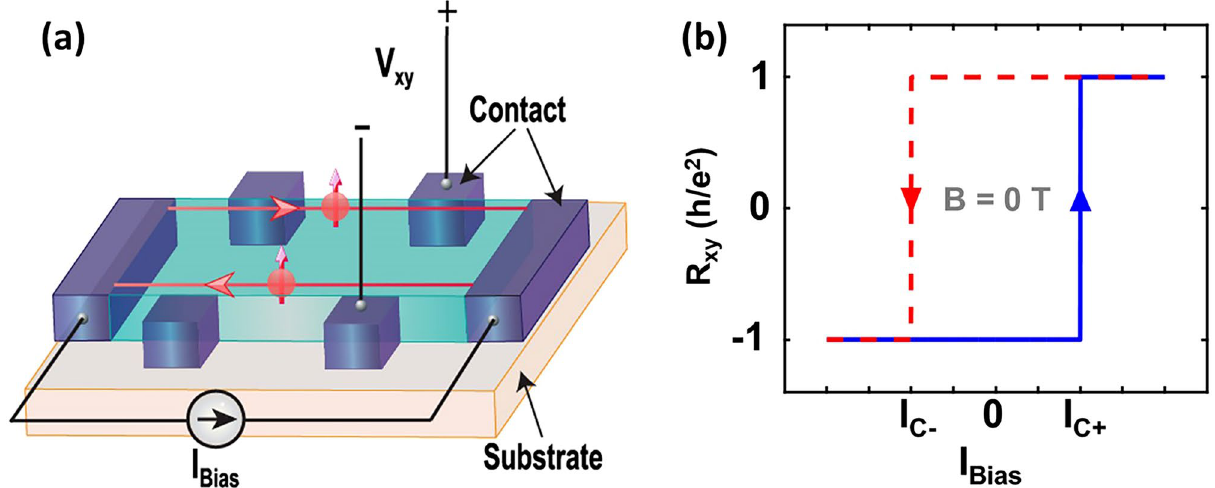
Figure 1. Schematic representation of quantum anomalous Hall effect. ( a ) Schematic of our device, where the red circles represent the electron and the red arrows show the spin of the electrons. A gate voltage can be applied at the back of the substrate to control the electronic density. V xx and V xy are the longitudinal and transverse (Hall) voltages, respectively, developed in response to the bias current, I Bias. ( b ) Illustration of the Hall resistance R xy versus the bias current, I Bias at zero external magnetic field. I C− and I C + are two critical values of I Bias which determine the hysteretic switching of R xy between − h/e 2 and h/ e 2